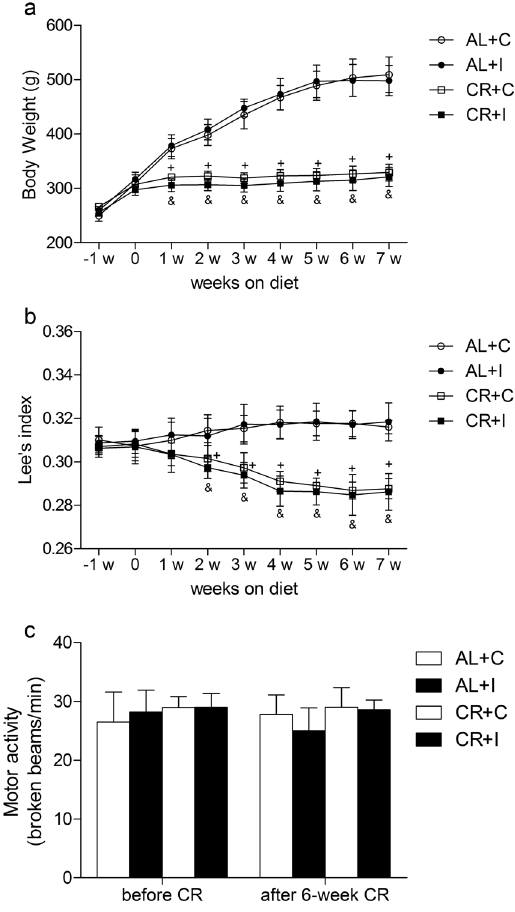
Figure 1. Effects of caloric restriction on Body weight, Lee’s index and motor activity. ( a ) Body weight (in grams) changes during the period of dietary treatment (n = 8). ( b ) Lee’s index changes during the period of dietary treatment (n = 8). ( c ) Locomotor activity in nonstressful conditions before and after a 6-week diet. Activity was indicated as broken beams per minute (n = 8). Values expressed as mean ± SD. AL + C: rats